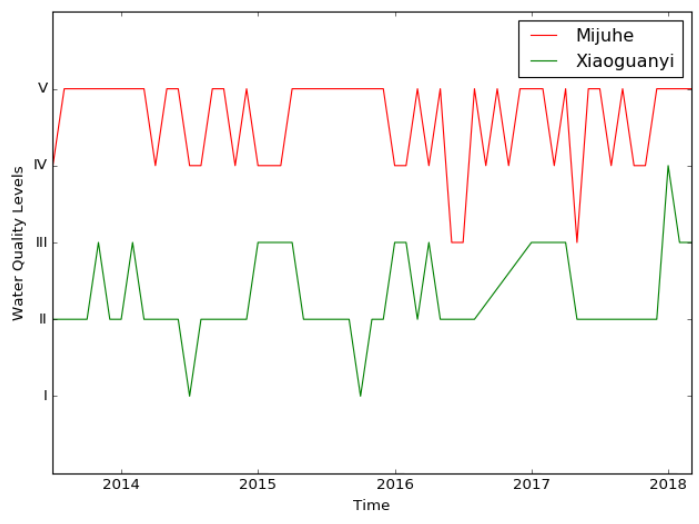
Figure 3. Monthly change of water-quality levels at 2 monitoring